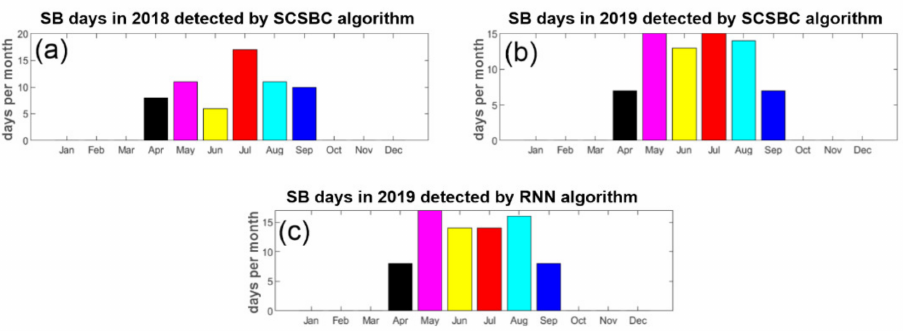
Figure 6. Identification of SB days using SCSBC algorithm from wind measurements in 2018 ( a ); 2019 ( b ). SB days identified by RNN algorithm, 2019 ( c ).